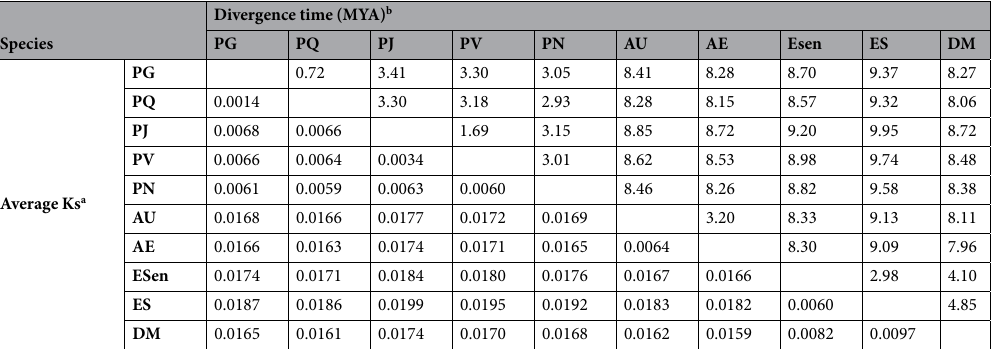
Table 2. Ks values and estimated divergence time of 10 Araliaceae species. a Average Ks values between common cp protein coding genes of each species calculated using KaKs calculator program. b Divergence time was estimated by Ks/2 λ , where λ = 1.0 × 10 − 9 . PG to DM indicate abbreviated species name (Table